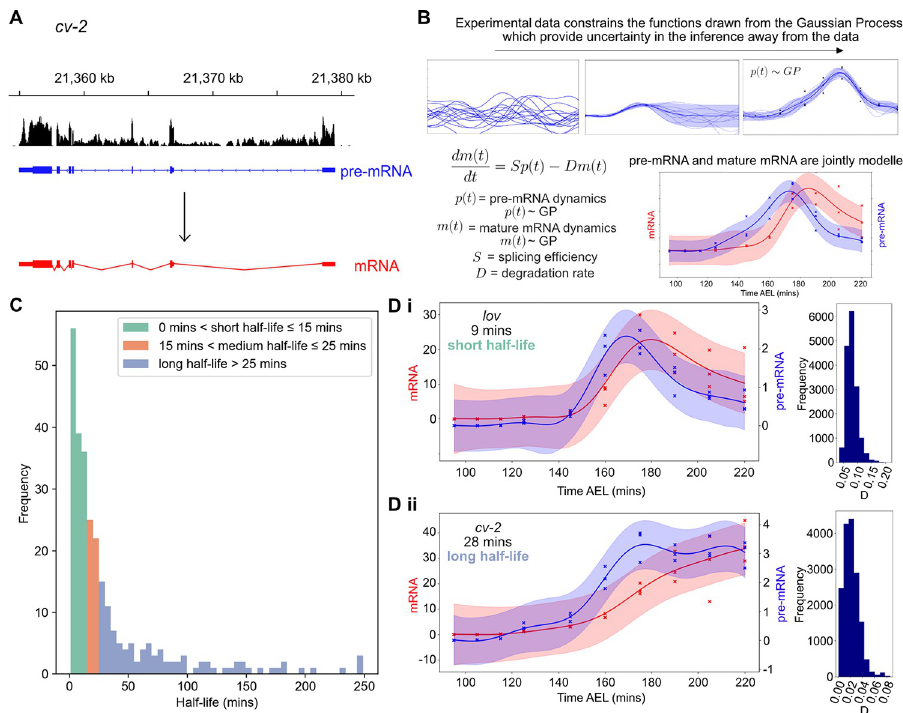
Fig 2. GP regression provides estimates of transcript half-lives in early embryogenesis. (A) Reads aligned to intronic and exonic regions of genes are used to represent pre-mRNA (blue) and mature mRNA levels (red), respectively. (B) Schematic of GP regression and the ODE model that shows the evolution of the mature mRNA dynamics is described by the pre-mRNA data over time, sculpted by the splicing ( S ) and degradation ( D ) parameters. Pre-mRNA and mature mRNA are therefore jointly modelled using GPs related by the ODE. (C) Half-life results for 263 transcripts estimated using the GP model. Transcripts are divided into short, medium, and long half-lives and coloured accordingly. (D) Examples of data for a short (Di) and a long (Dii) half-life mRNA, lov and cv-2 , respectively, fit using the GP model. Pre-mRNA is shown in blue and mature mRNA in red, shaded areas represent credible regions and crosses mark the data for each experimental replicate at each time point. Posterior distributions for the degradation parameter D for each mRNA are shown to the right. Underlying data can be found in S1 Data, S1 and S2 Tables. GP, Gaussian process; ODE, ordinary differential